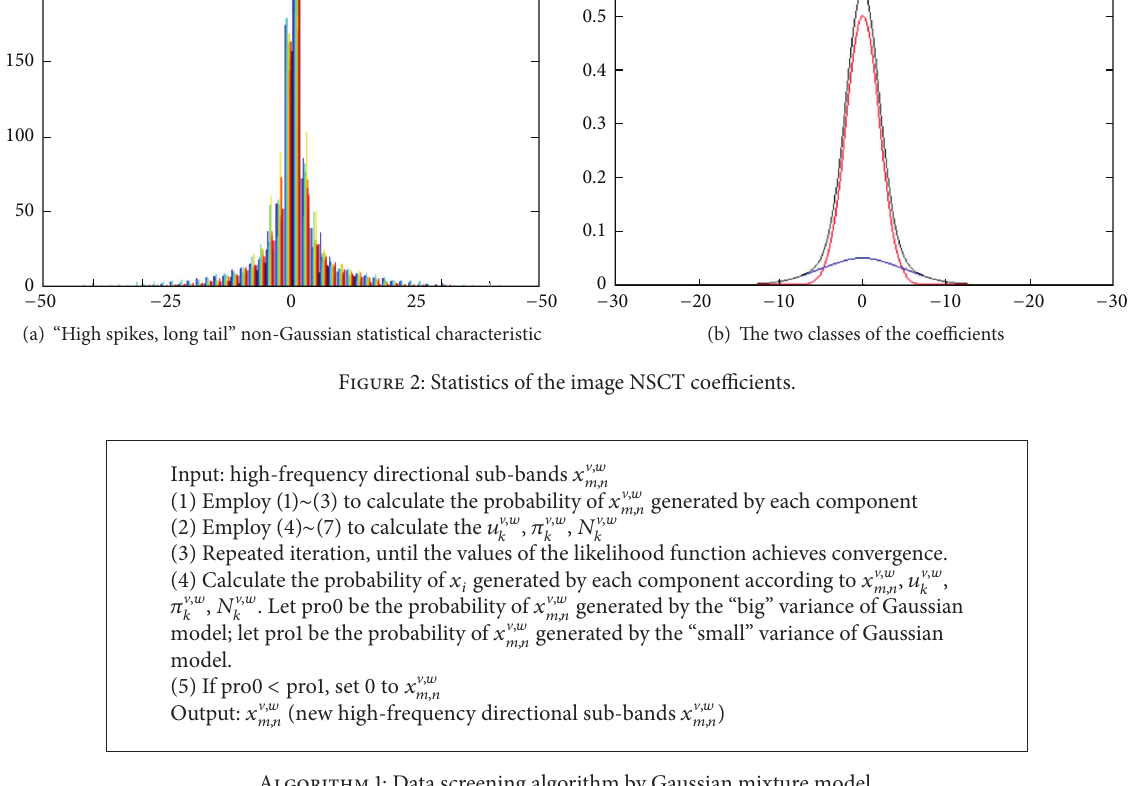
Algorithm 1: Data screening algorithm by Gaussian mixture